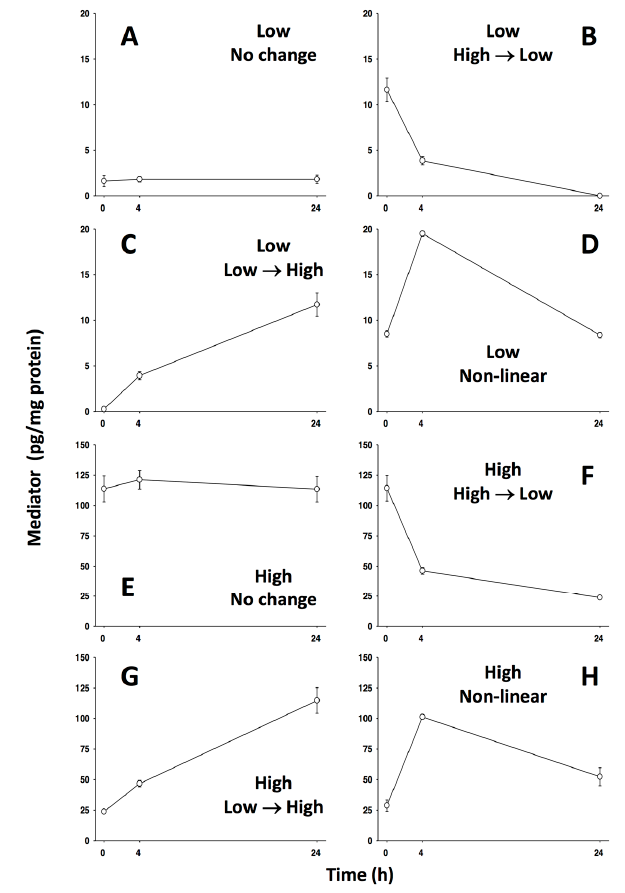
Figure 1. Modeling Methods Example Data: Artificially generated data representing variables of varying levels (high or low) and direction (increasing, decreasing, or non-linear).